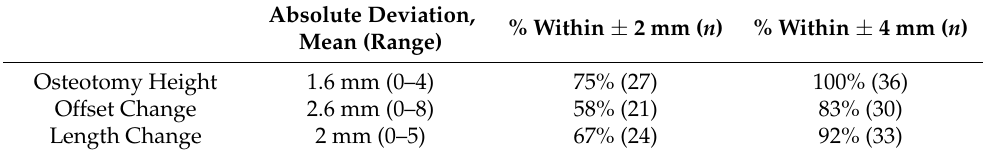
Table 3. Deviation from the planned